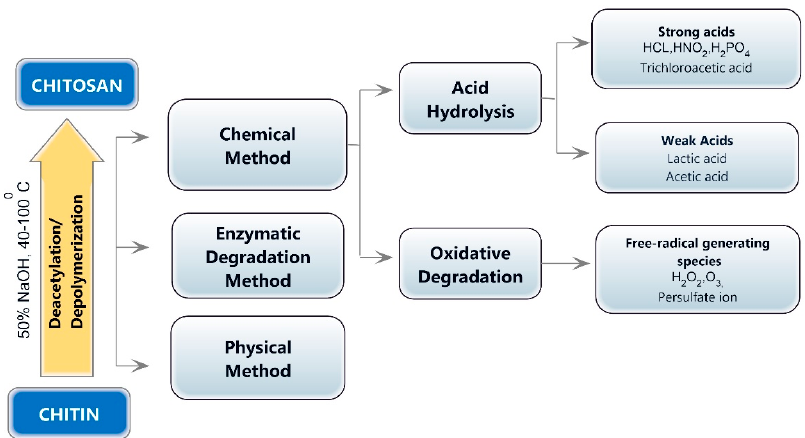
Figure 2. Various methods of chitooligosaccharide